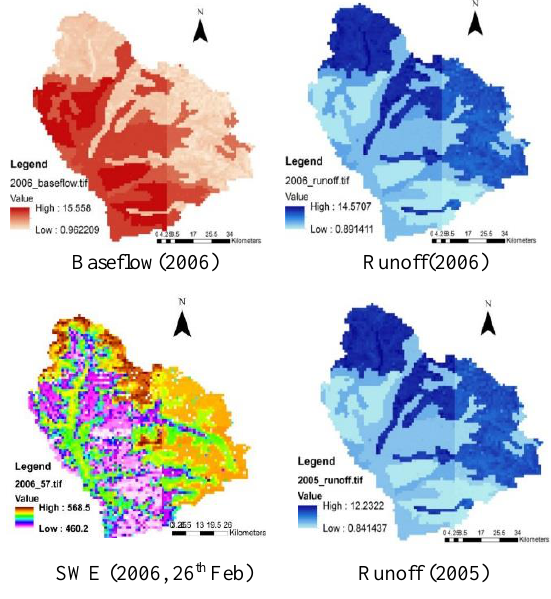
Figure 5.7. Comparison of temperature data sources for year